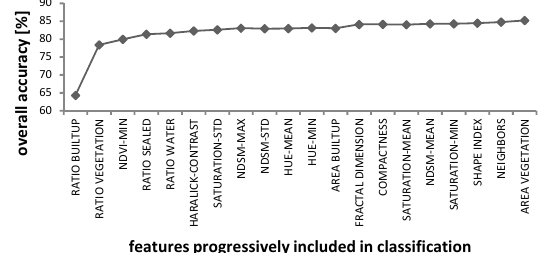
features progressively included in Figure 3: Overall accuracy as a function of the features used for classification, progressively included in classification according to their importance value.